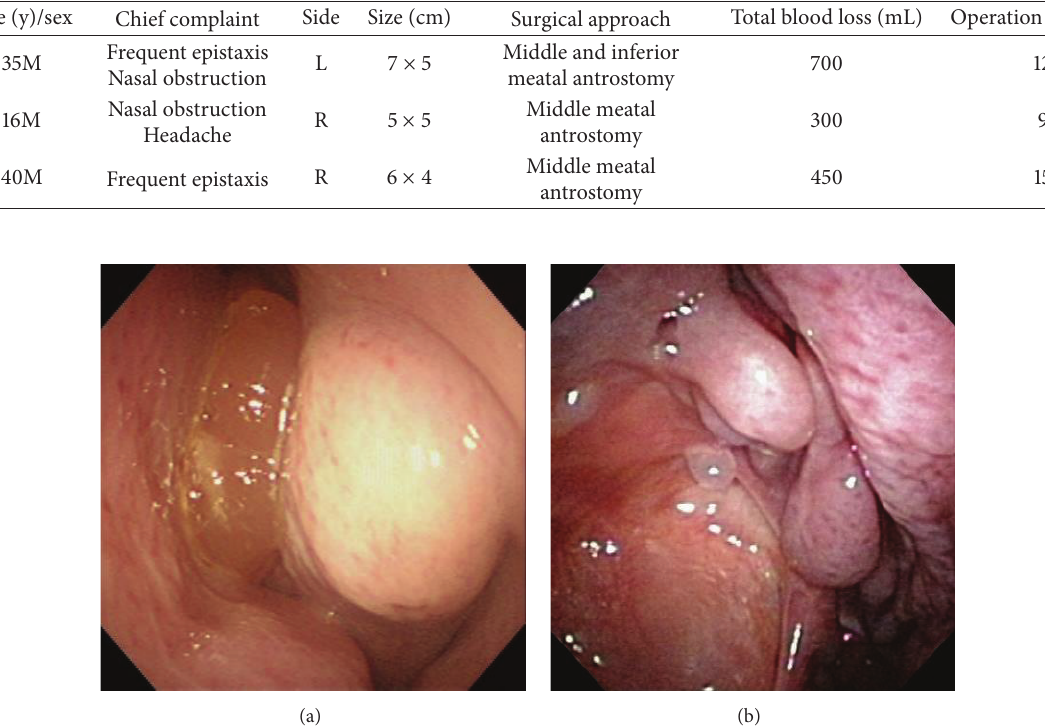
Figure 1: On paranasal endoscopy, an extension of the medial wall of the right maxillary sinus to the nasal side with a polyp is observed in Case 1 (a). Postoperatively, the maxillary sinuses are well-opened, and no evidence of recurrence is observed